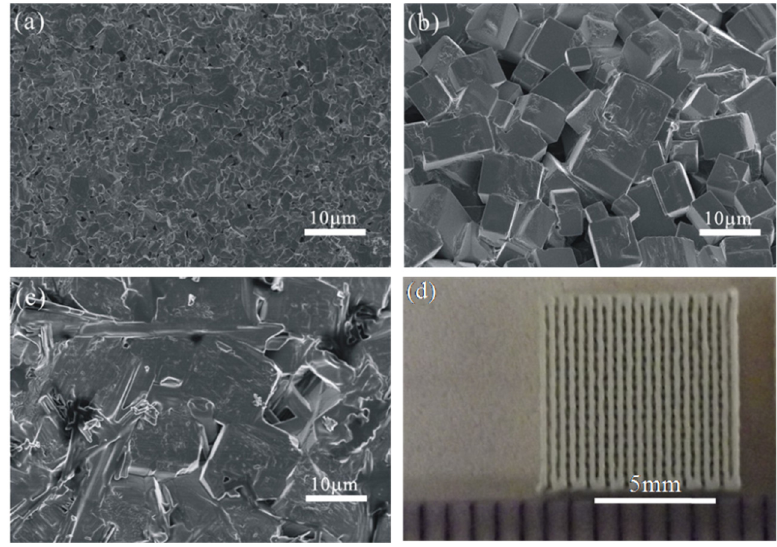
Figure 5. SEM photos of KNN samples sintered to varying maximum